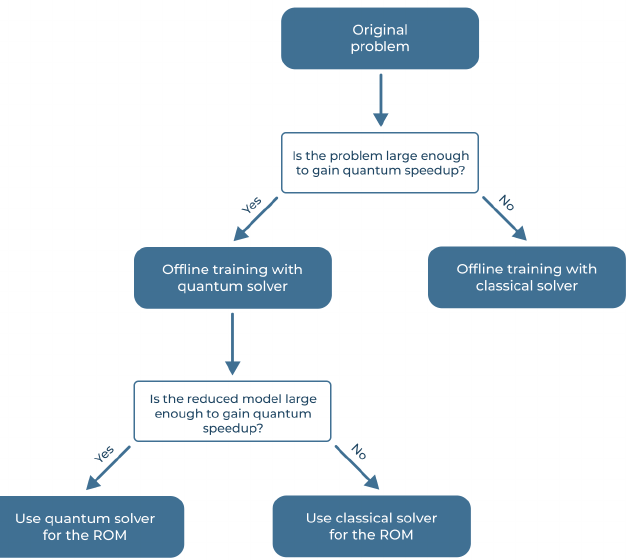
Figure 8. Decision tree for whether it is worth using quantum solver over classical ones. The same question can be applied for both the original large system and its corresponding reduced